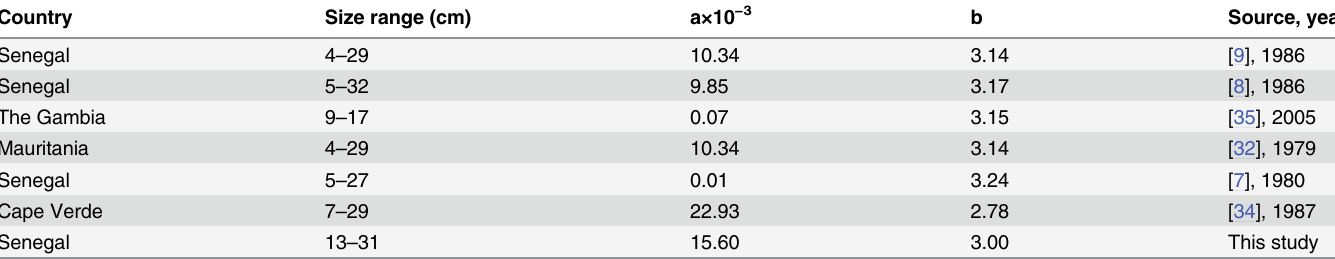
Table 5. Length-weight parameters in West Africa for Sardinella maderensis . The length is expressed as fork length. Country Size range (cm) a×10 − 3